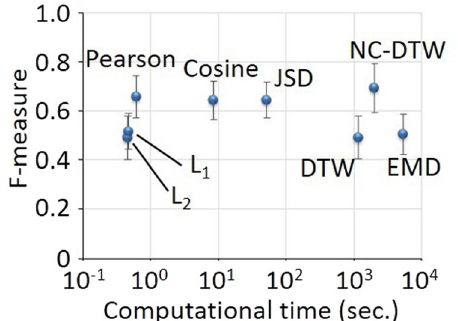
Fig. 4 The computational cost and F -measure for each measure. F -measure statistics were computed over the various clustering techniques and over the range of cluster number 2 –